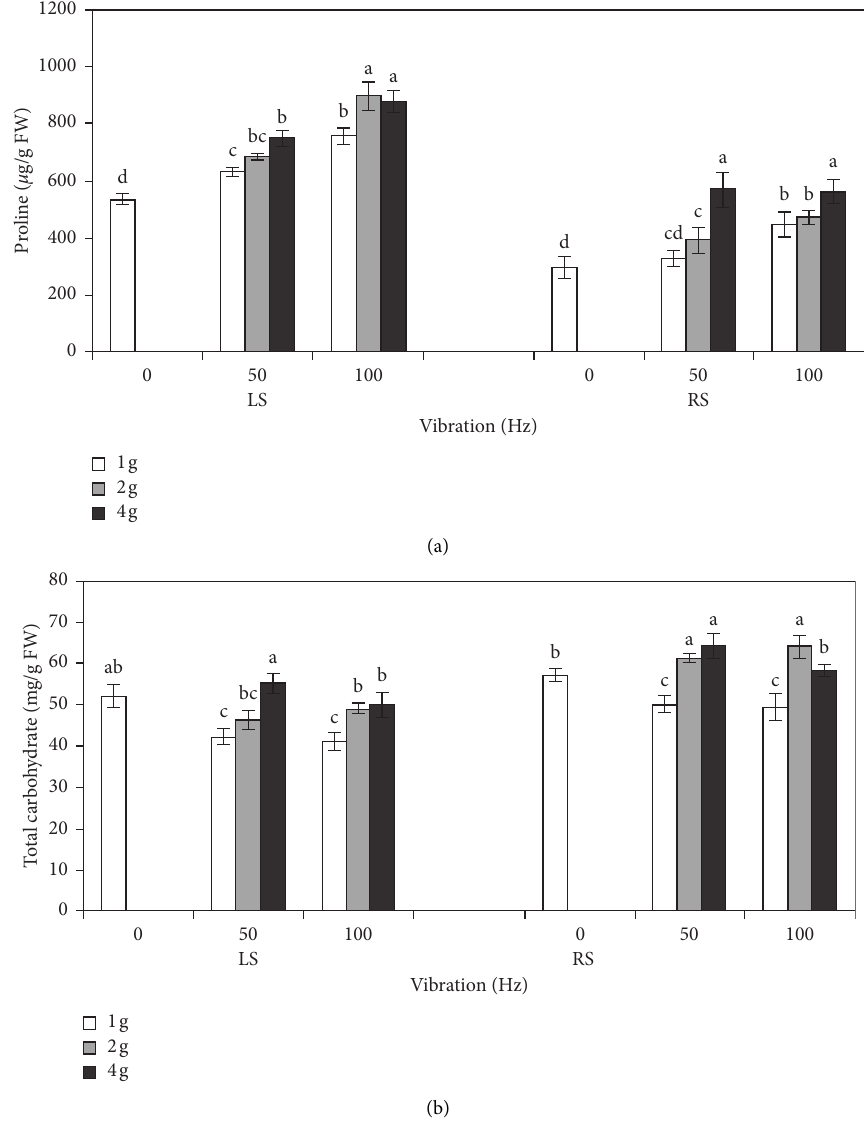
Figure 2: Effect of different sinusoidal vibrations (0, 50, and 100Hz) and accelerations (1, 2, and 4g) on proline (a) and total carbohydrate (b) accumulation of A. gilanica calli. Bars indicate mean ± SE ( n � 4) in each group. Different letters indicate significant differences at P < 0 . 05